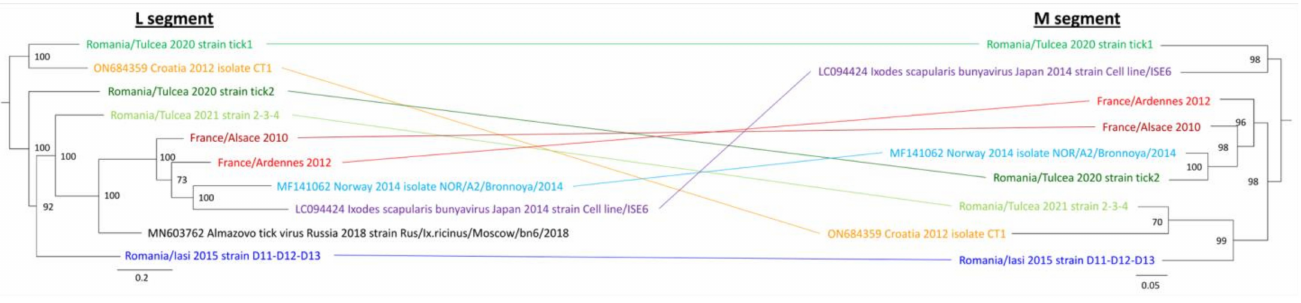
Figure 4. Compared phylogenetic reconstructions of Bronnoya-related viruses L (left) and M (right)